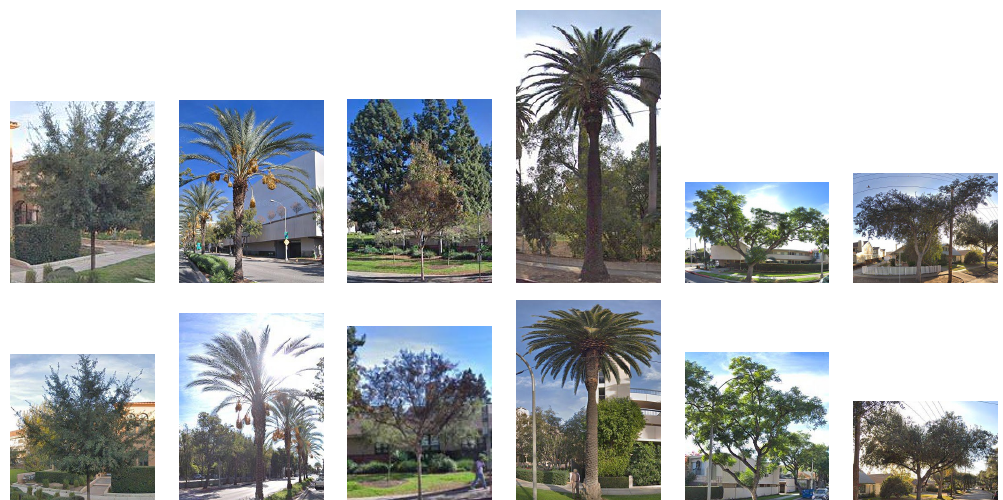
Figure 8. Pairs of Pasadena candidate matches ( top and bottom rows) that are correctly classified using our method ( Ours ) in comparison to the appearance-based only method ( w/o Geometry ). The first three columns show difficult situations correctly resolved as matches by Ours despite significant change in perspective, illumination, and background. Columns 4–6 (from left) show similar looking, neighboring trees correctly classified as not matching by Ours . (Imagery c (cid:13) 2019 Google).